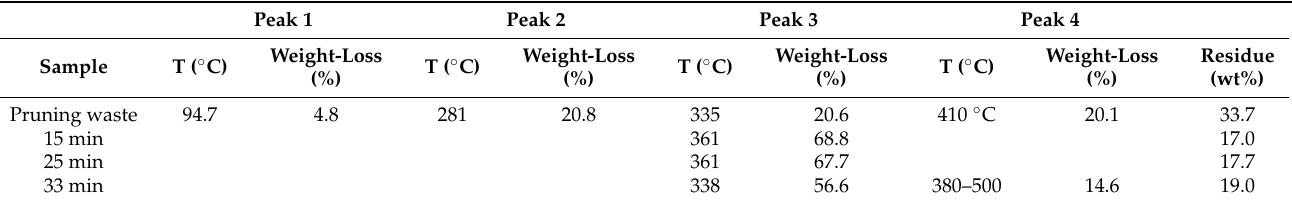
Table 2. Data obtained from DTA